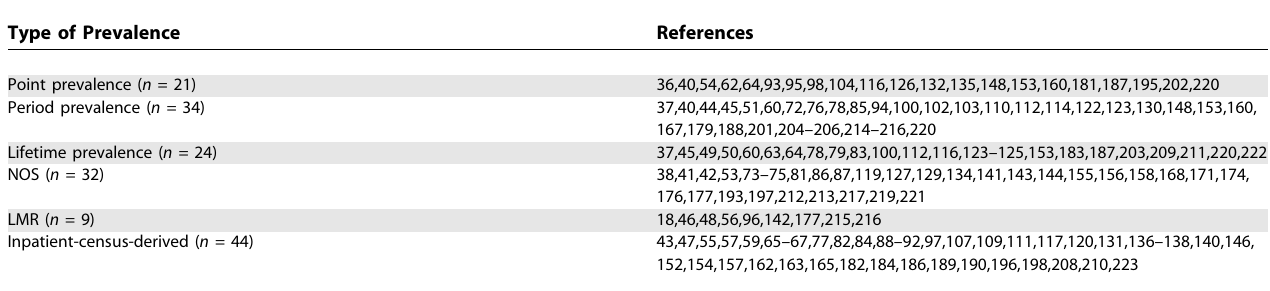
Table 2. References by Type of Prevalence